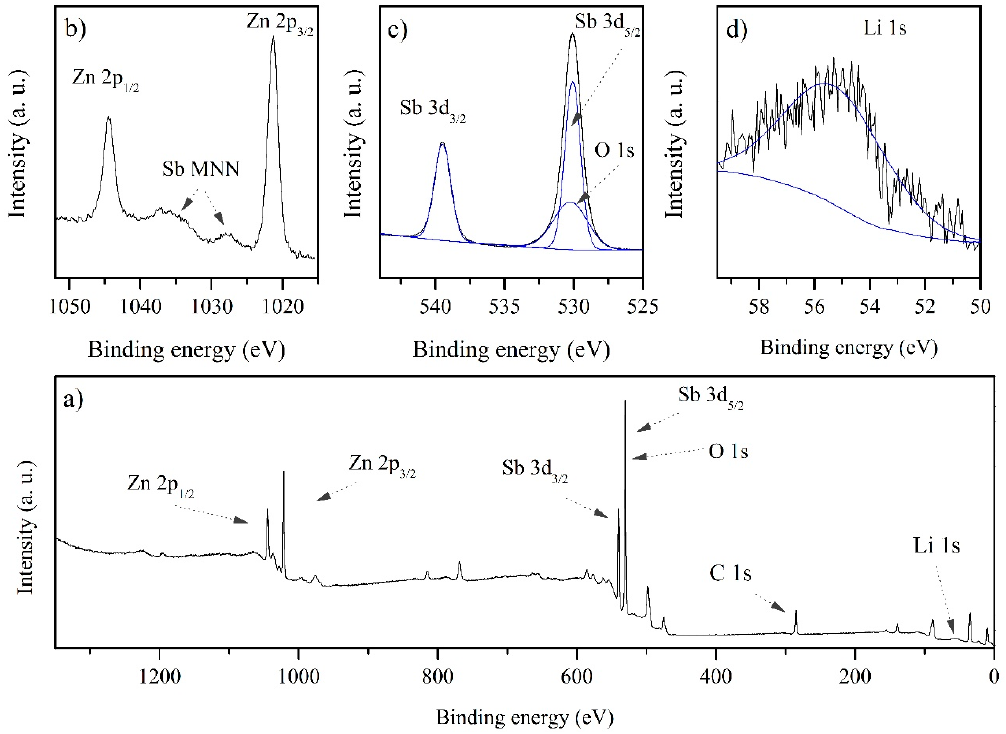
Figure 5. XPS spectrum for ( a ) Li 1.5 Zn 5 Sb 2.5 O 12 and high-resolution spectra ( b – d ) for Zn, Sb, O, and Li, respectively.